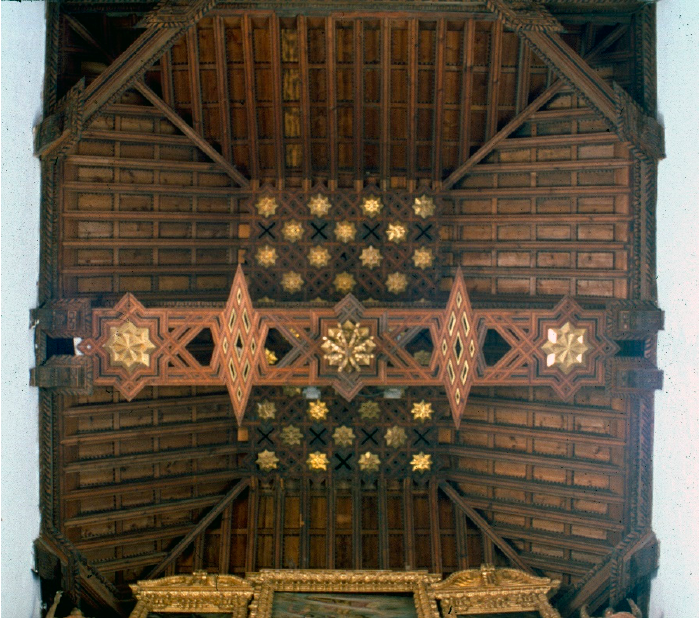
Figure 1. Main chapel’s ceiling of San Francisco church. Tlaxcala. Photo took by author.